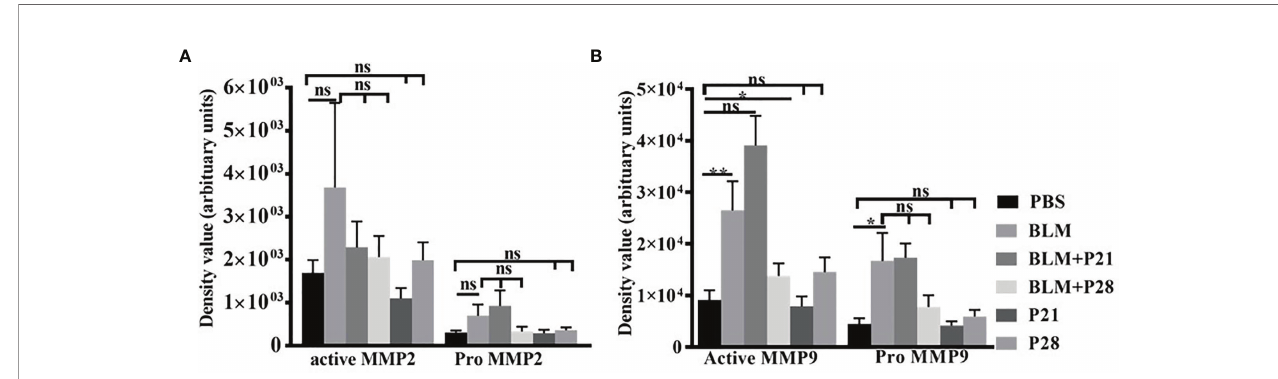
FIGURE 4 | The effect of Progesterone on density values of gelatinases in lung tissue. Lung tissues were processed for gelatine zymography then densitometric analyses of zymograms were done by image J software. (A) Density values of MMP2. (B) Density values of MMP9. Results represented as mean ± SEM, n = 8-10 mice in each group. Data were analyzed with One – way ANOVA, Tukey multiple comparisons test. BLM, Bleomycin; P, Progesterone; MMP, matrix metalloproteinase; ns, non-signi fi cant, ** = P < 0.01, * = P < 0.05.